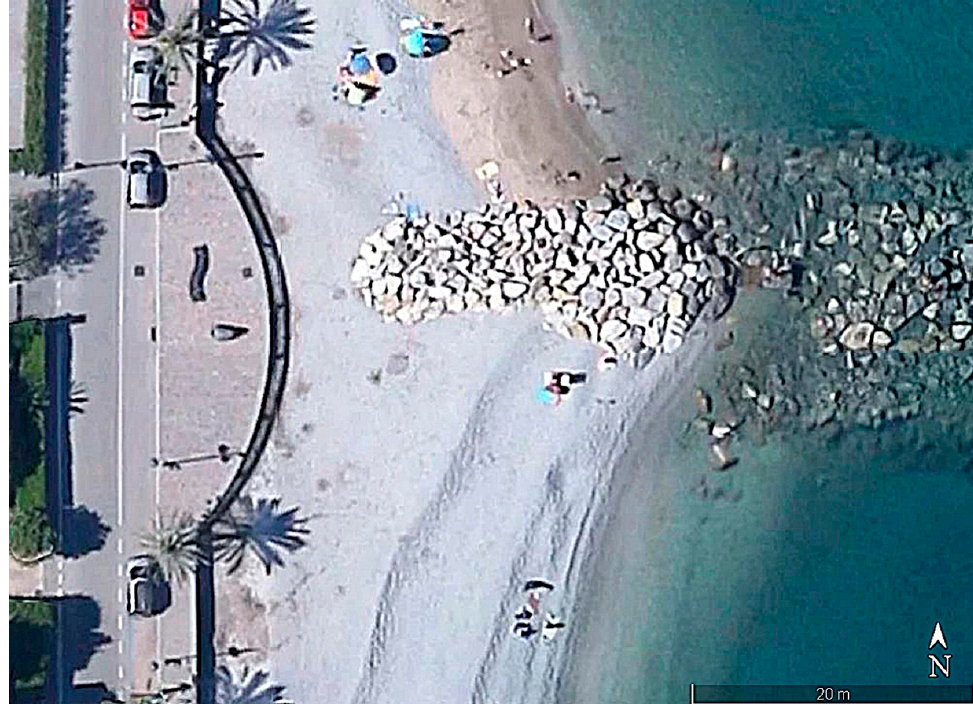
Figure 6. One of the two exedras constructed along the promenade (Google Earth).